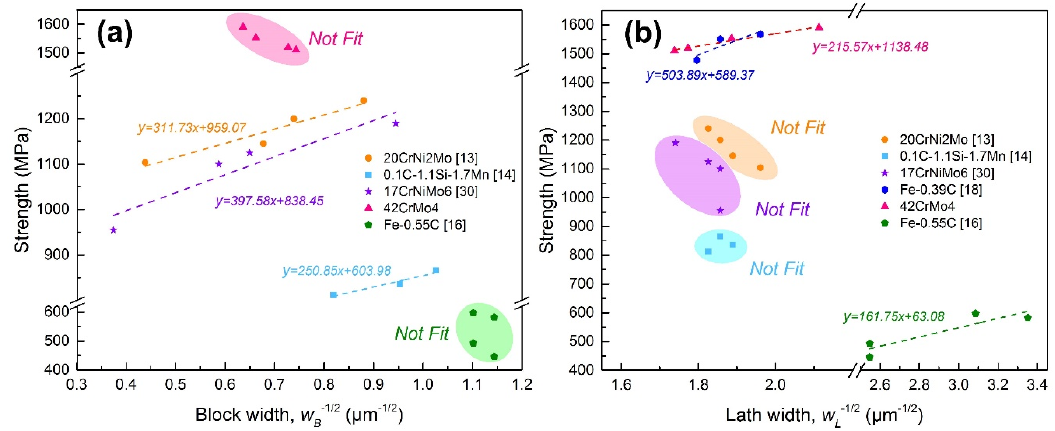
Figure 11. Yield strength as a function of ( a ) block width and ( b ) lath width.